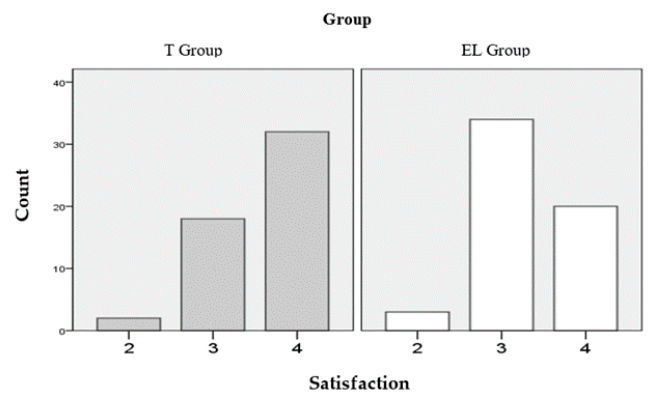
Figure 7. Level of satisfaction (general assessment) after taking the course (Likert scale of four items from 1 = not at all adequate to 4 = very adequate).